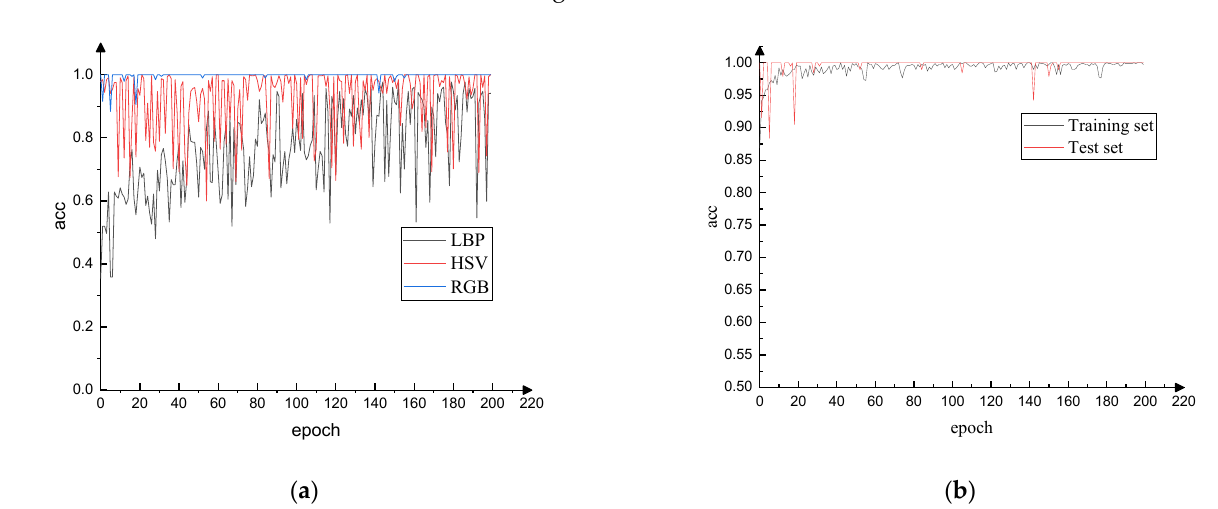
Figure 15. ( a ) Test accuracy of different datasets; ( b ) Training and test accuracy of RGB dataset.